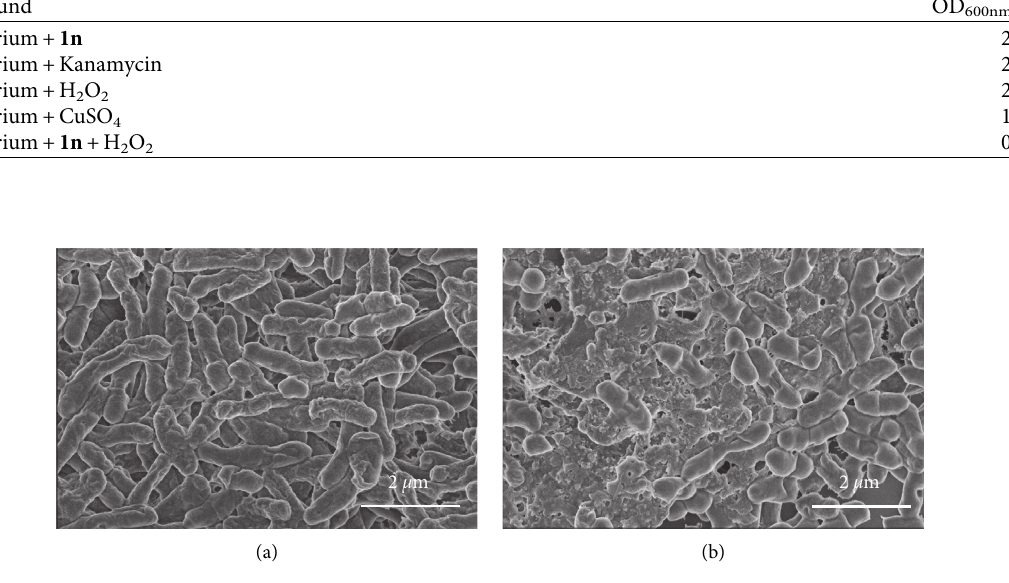
Table 1: OD values at 600nm of the Sphingobacterium in the presence of kanamycin antibiotic, H Strain/compound OD 600nm , 24h 37 ° C